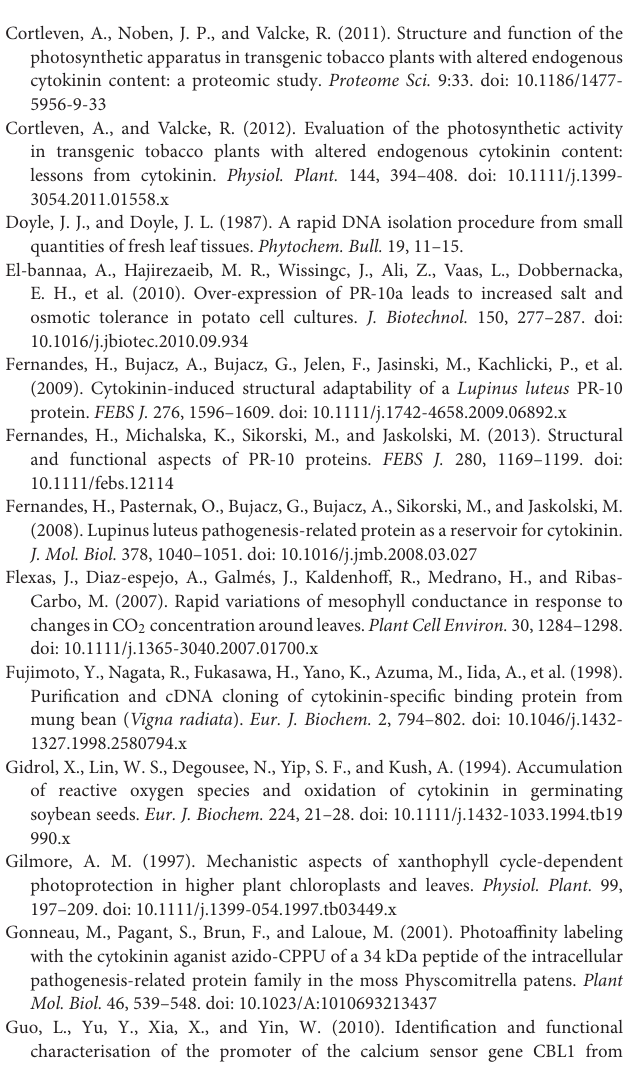
FIGURE S1 | Characterisation of transgenic tobacco plants. (A) Schematic representation of the pCAMBIA1301 – 35S: JcPR-10a construct used for Nicotiana tabacum transformation. (B) GUS assay of T 0 leaf and T 1 seedlings showing positive expression in the transgenic lines and negative expression in WT plants. PCR confirmation of transgenic lines with (C) GUS, (D) hptII, and (E) JcPR-10a primers. (F) GUS:NRA ratio for determination of copy number of transgene insertion in transgenics. Table S1 | List of primers used in this study. Table S2 | Segregation ratio of